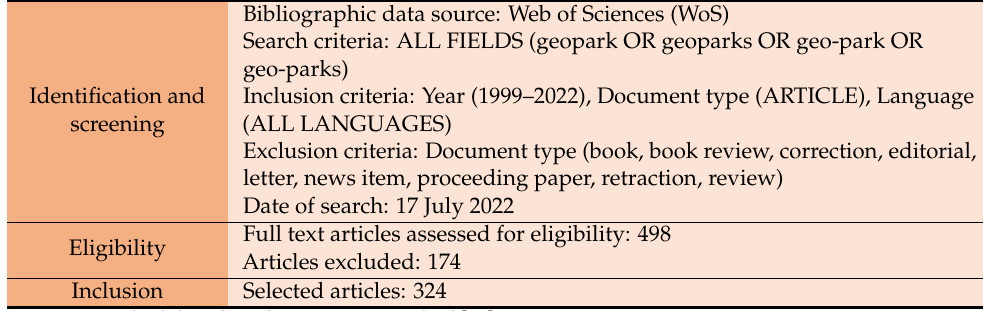
Table 1. Phases of research methodology based on